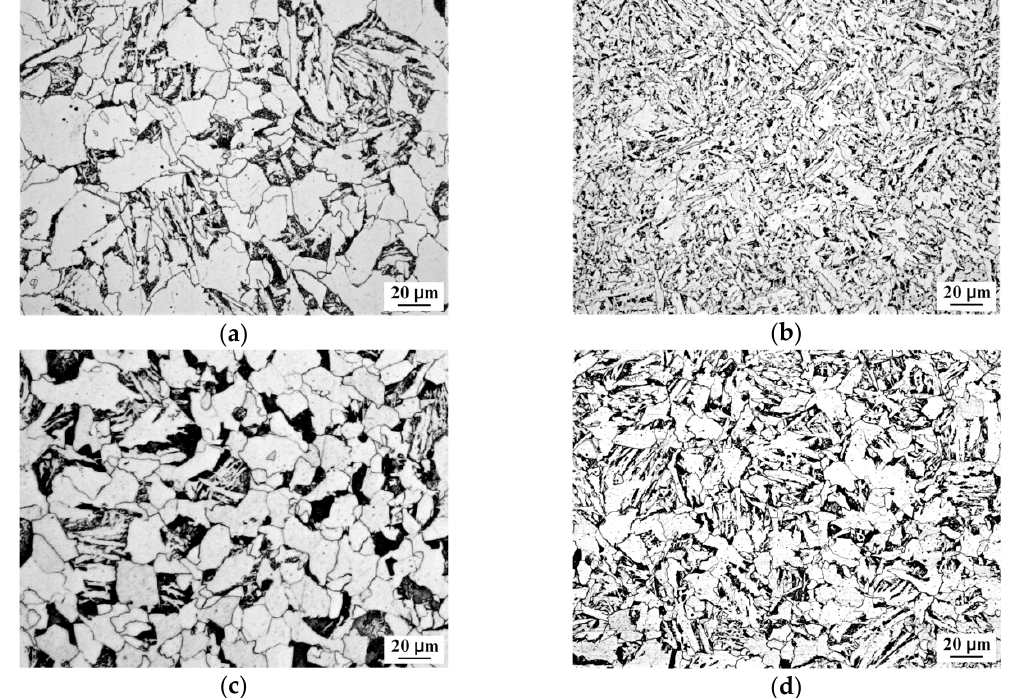
Figure 9. Microstructures of hot-rolled ( a , b ) TC# steel and ( c , d ) AC# steel with ( a , c ) air cooling and ( b , d ) accelerated water cooling conditions.